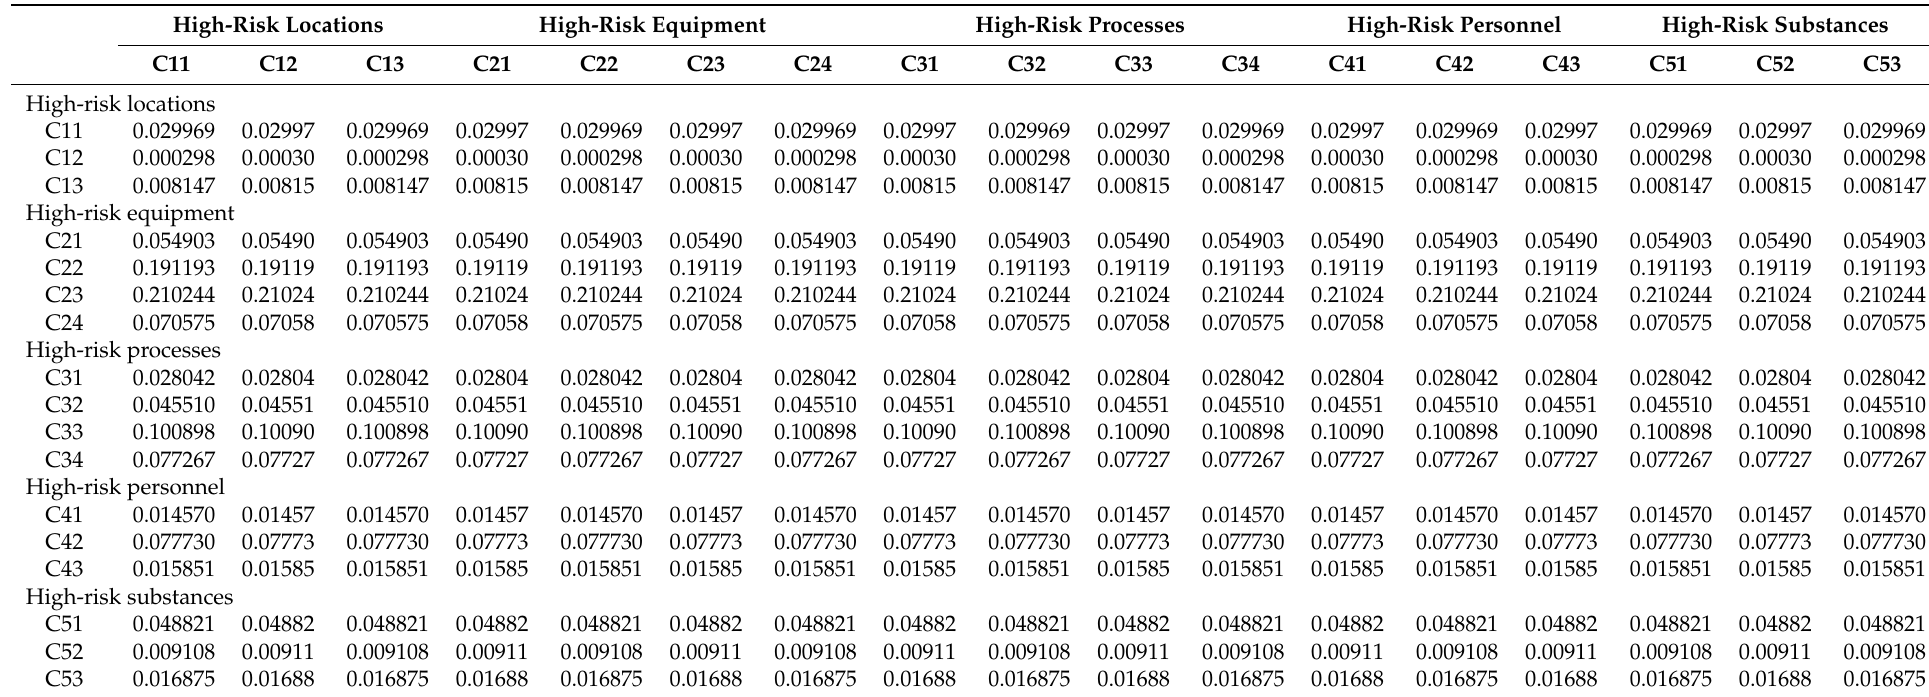
Table 5. Limiting super